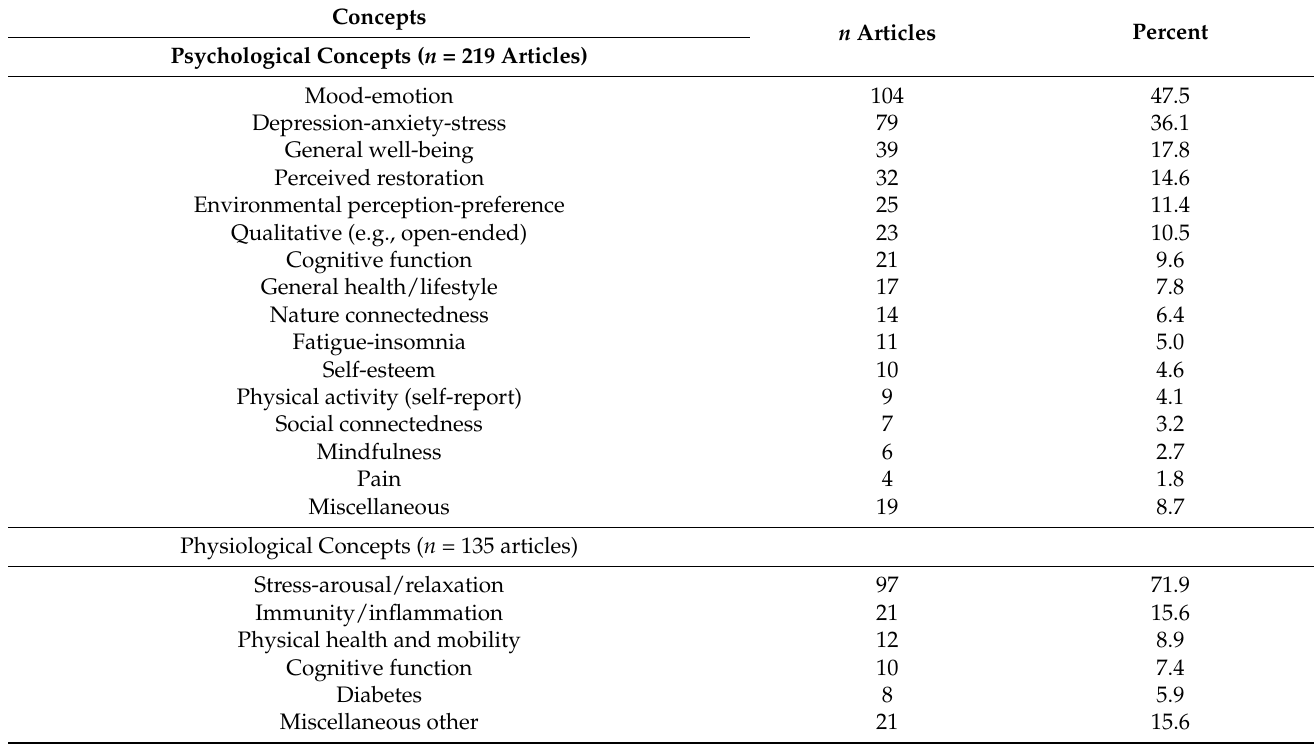
Table 1. Concepts measured by psychological and physiological indicators in the article set.